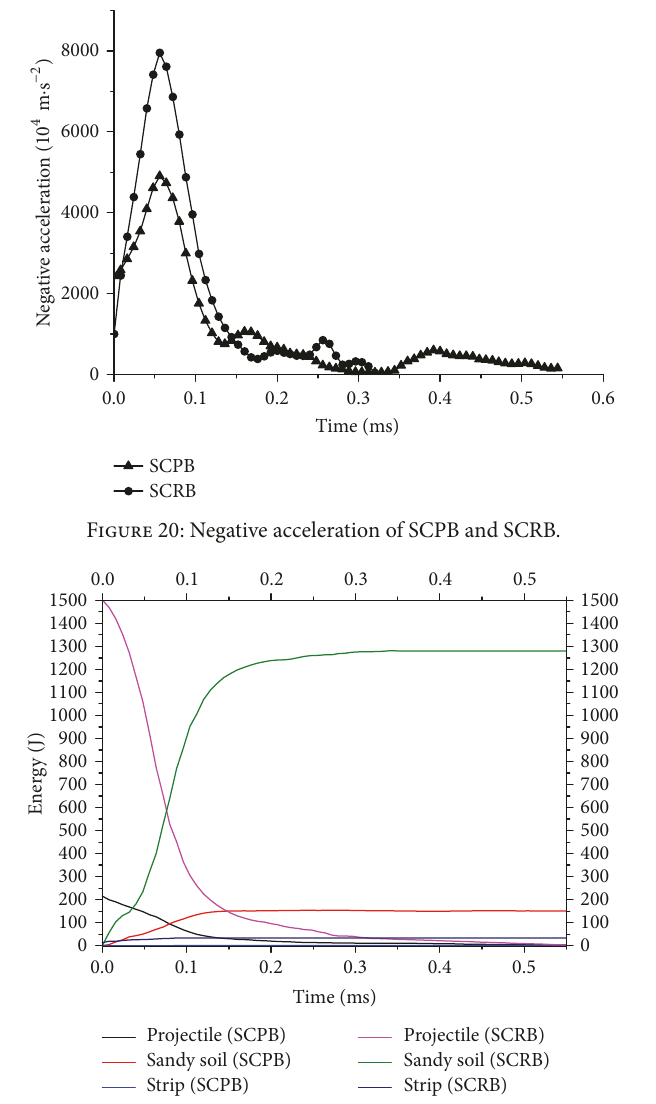
Figure 21: Energy transfer during the penetration.